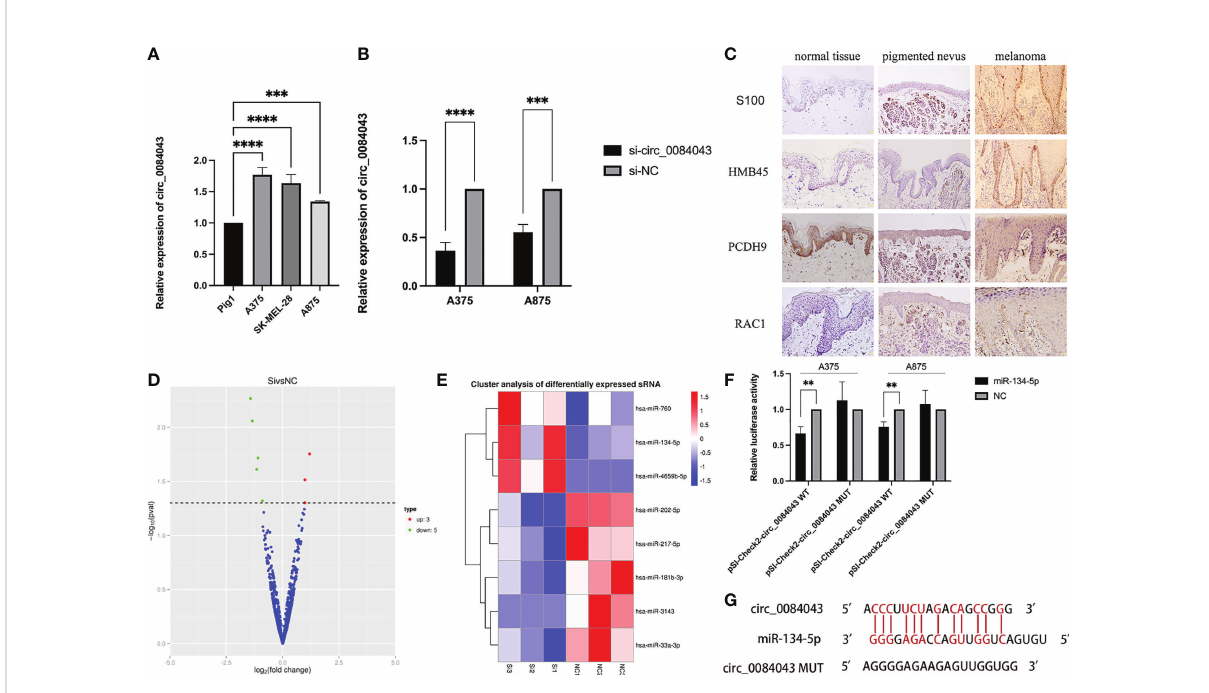
FIGURE 5 qRT-PCR results showed the expression of circ_0084043 in human melanoma cell lines (A375, SK-MEL-28, and A875) and normal human epidermal melanocytes cell line (PIG1) (A) . Circ_0084043 was knocked down in A375 and A875 cells by siRNA (B) . Data represent mean ± SD from three independent experiments. ** p < 0.01, *** p < 0.001 and **** p < 0.0001 compared with control groups by using Student ’ s t-tests. Immunohistochemical analyses of PCDH9 and RAC1 expression in normal skin, pigmented nevus, and melanoma tissue. The